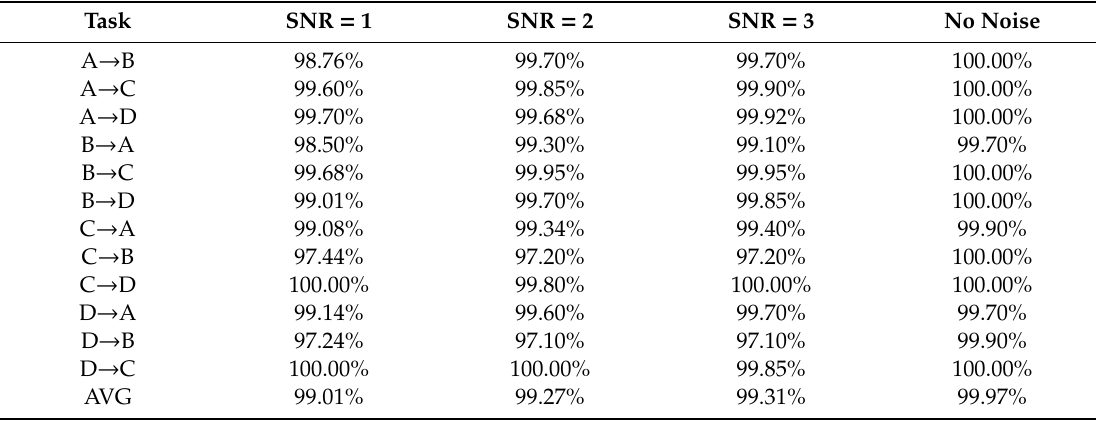
Table 5. The diagnosis accuracy (%) of 1D-MSDAN under di ff erent noisy